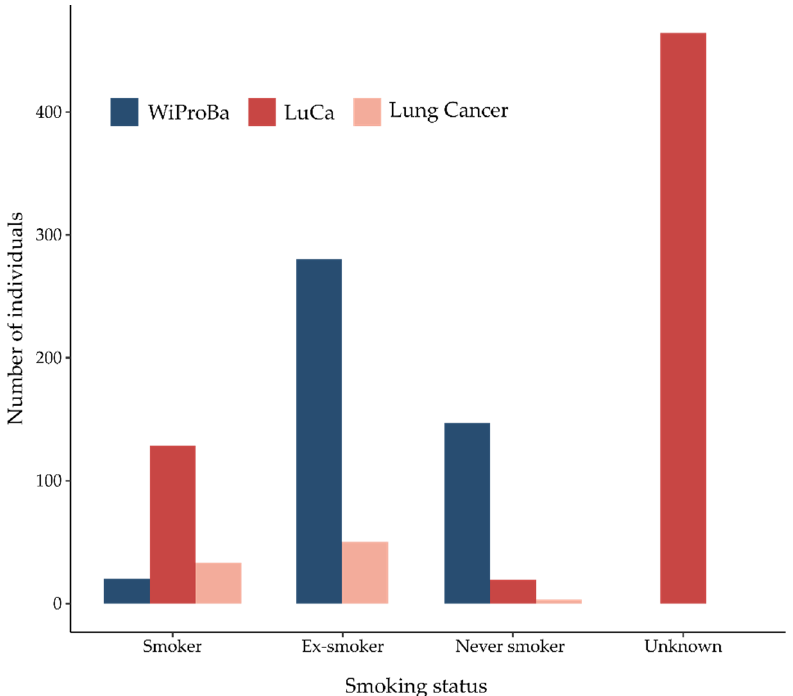
Figure 3. Smoking status in the three subgroups: WiProBa, LuCa and lung cancer. The smoking status was unknown for more than two-thirds of the individuals in the LuCa subgroup.